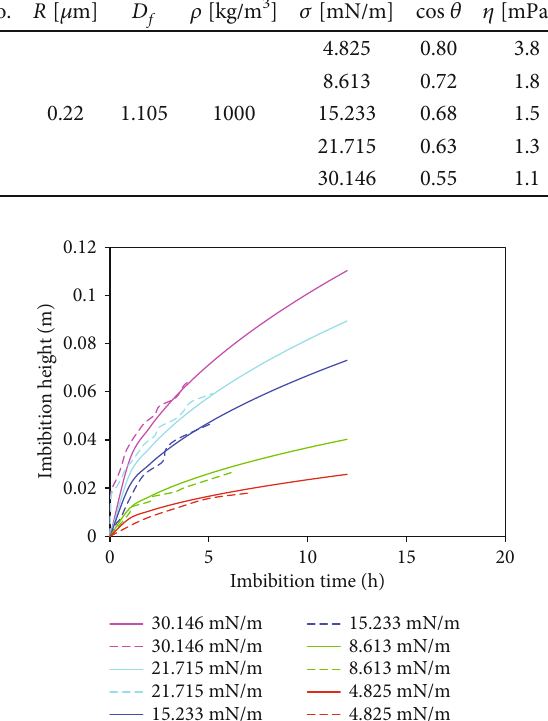
Figure 7: Comparison between the experimental results and calculation results obtained by the improved capillary model under di ff erent interfacial tensions. The dotted line indicates experimental results, and the solid line represents the calculated